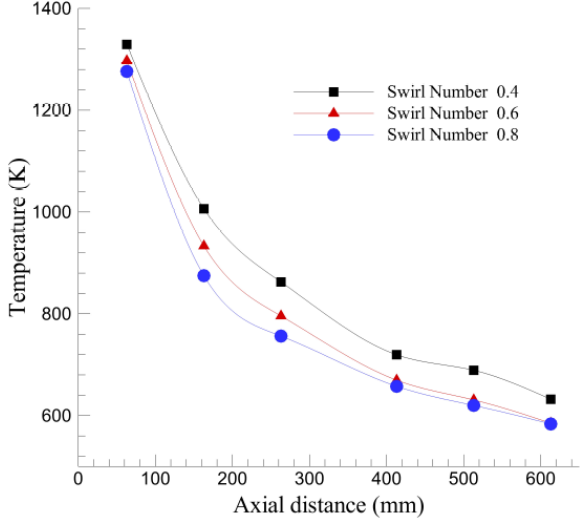
Figure 8: Axial temperature distributions of 60% CNG - 20% H 2 - 20% CO 2 mixture (Swirl numbers: 0.4, 0.6 and 0.8).